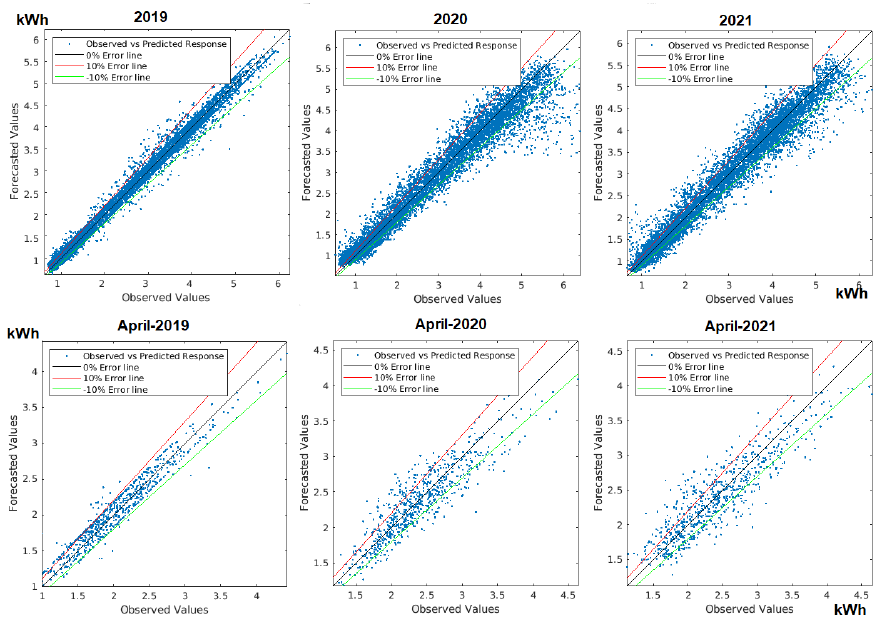
Figure 18. Observed vs. predicted values for day-ahead forecasting using the SVR approach for the AC-included cooling